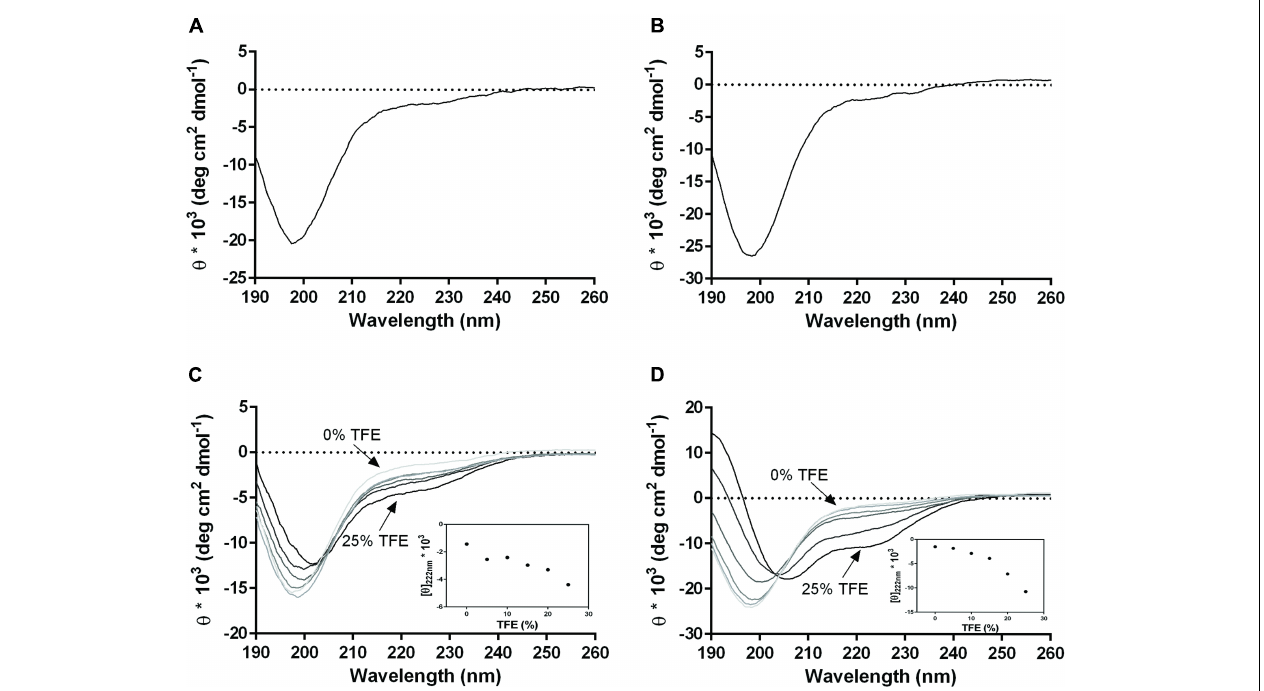
FIGURE 2 | CD spectra of PS1-70 and PS1-120 and TFE titration. Far-UV CD spectra of (A) PS1-70 and (B) PS1-120. CD spectra overlapping of (C) PS1-70 and (D) PS1-120 recorded at increasing concentrations of TFE (0, 5, 10, 15 20, and 25%). Changes in molar ellipticity at 222 nm, as a function of TFE percentage are shown in the inset for both fragments. Spectra were acquired at 20 ◦ C in 10 mM phosphate buffer, pH 7.4.